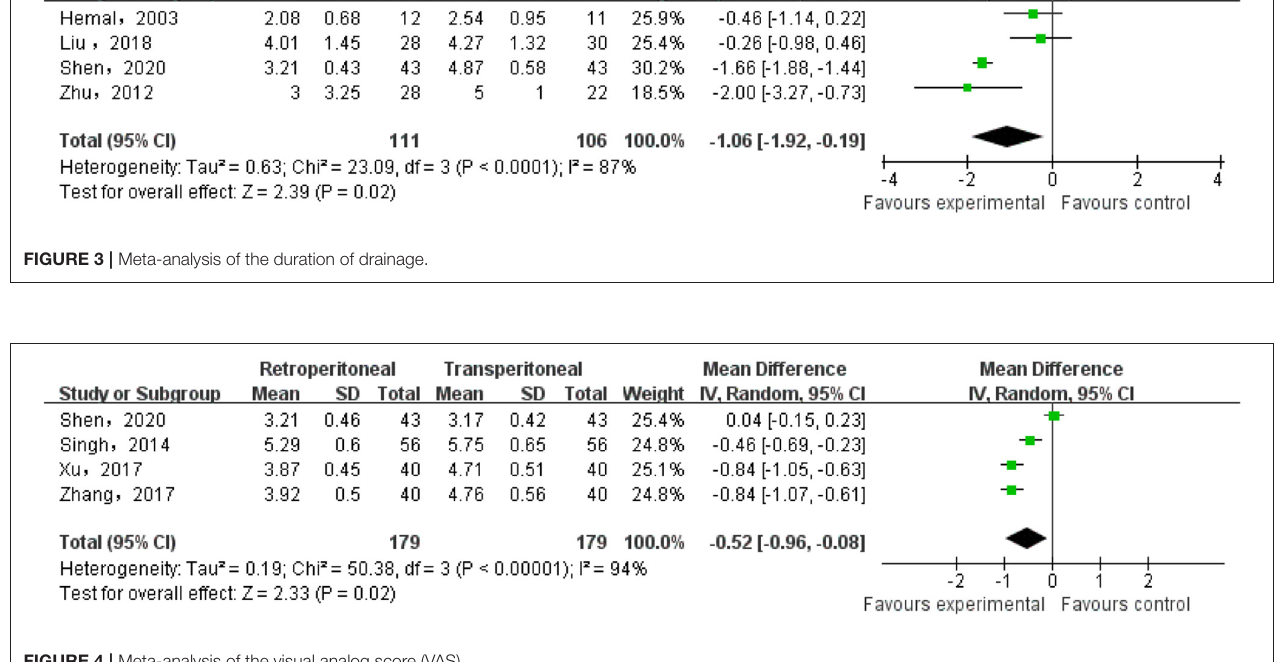
FIGURE 4 | Meta-analysis of the visual analog score